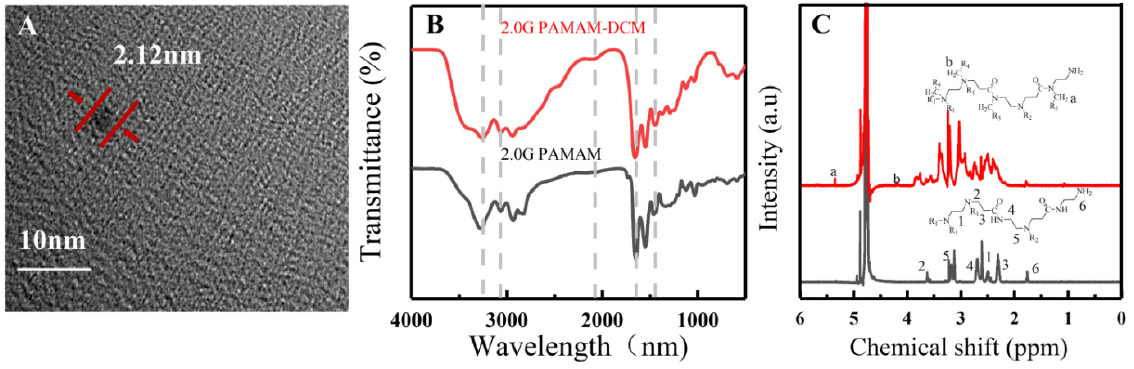
Figure 1. ( A ) TEM image of 2.0G PAMAM-DCM PDs. ( B ) FT-IR spectra and ( C ) 1 H NMR of 2.0G PAMAM and 2.0G PAMAM-DCM.